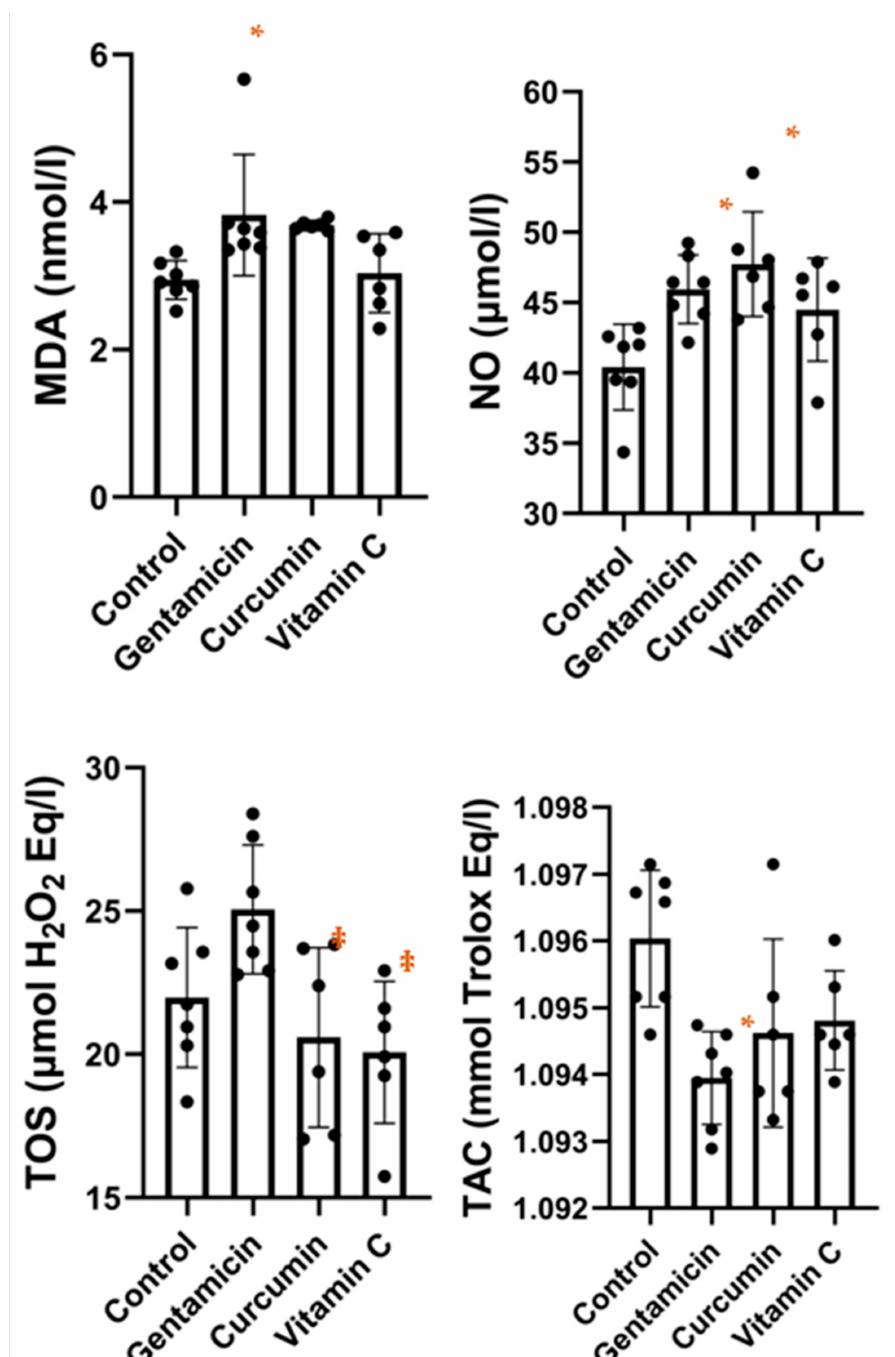
Figure 2. Box-plot displaying serum malondialdehyde, nitric oxide, total oxidative stress, and total antioxidant capacity concentrations in our study groups (* p < 0.05 vs. control; ‡ p < 0.05 vs. gentamicin). No significant differences were found for thiols (ANOVA p = 0.1062), 3-NT (ANOVA p = 0.551) and IL-10 (ANOVA p = 0.2321) between our study groups (Figure